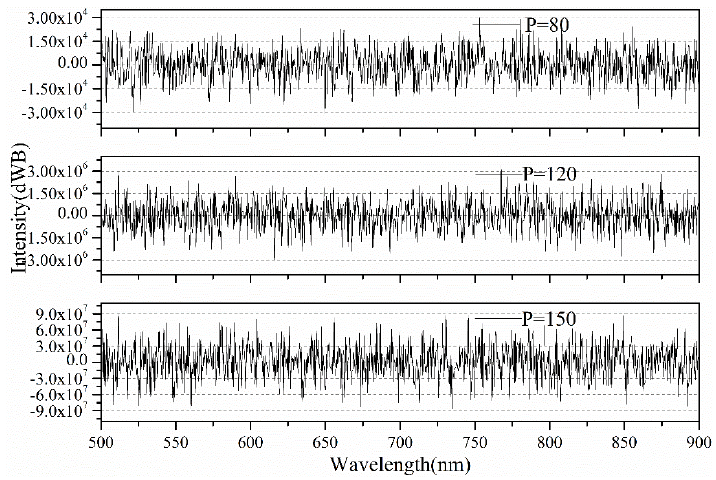
Figure 3. Three types of simulated noise spectra with different p values.